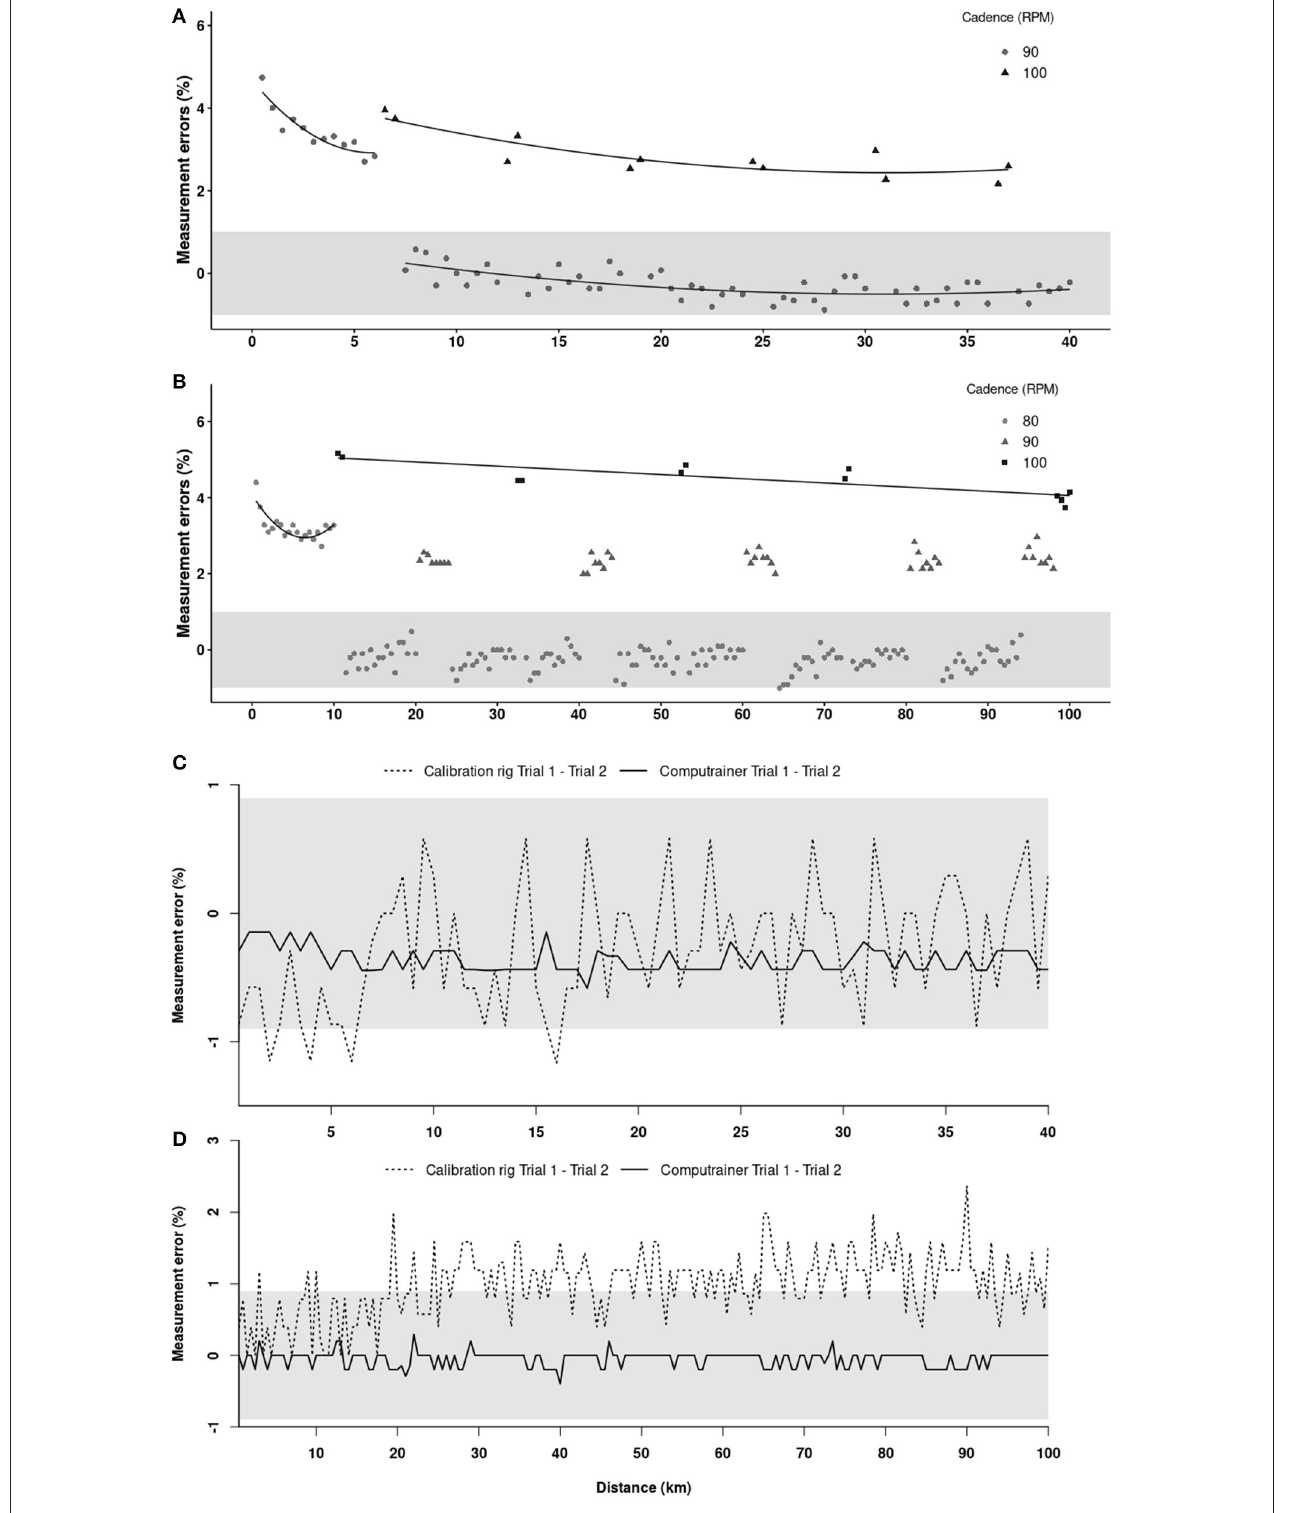
FIGURE 3 | Changes in measurement errors associated with the different cadences imposed over time during the 40 (A) and 100 (B) km time-trials and between the first and second trial completed as measured by the Racermate One TM software and the calibration rig during the 40 (C) and 100 (D) km time-trials. The shaded areas represent the calibration rig’s measurement